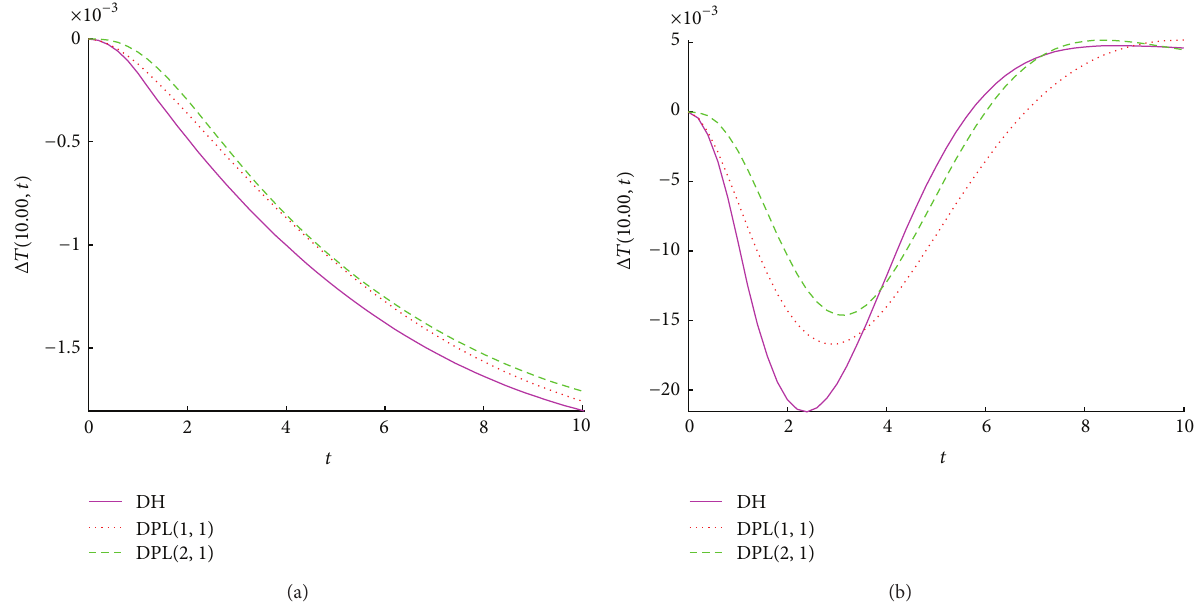
Figure 2: Differences from classical diffusion for models DPL and DH, for the data shown in Figure 1.